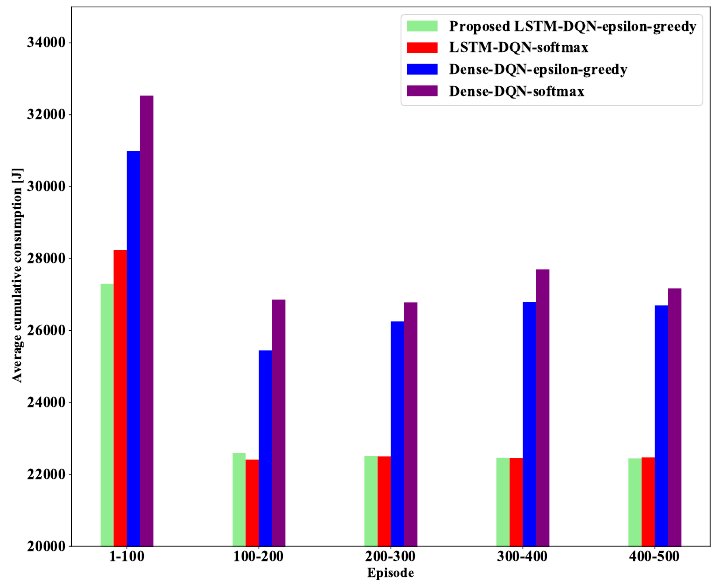
Figure 13. Average cumulative energy